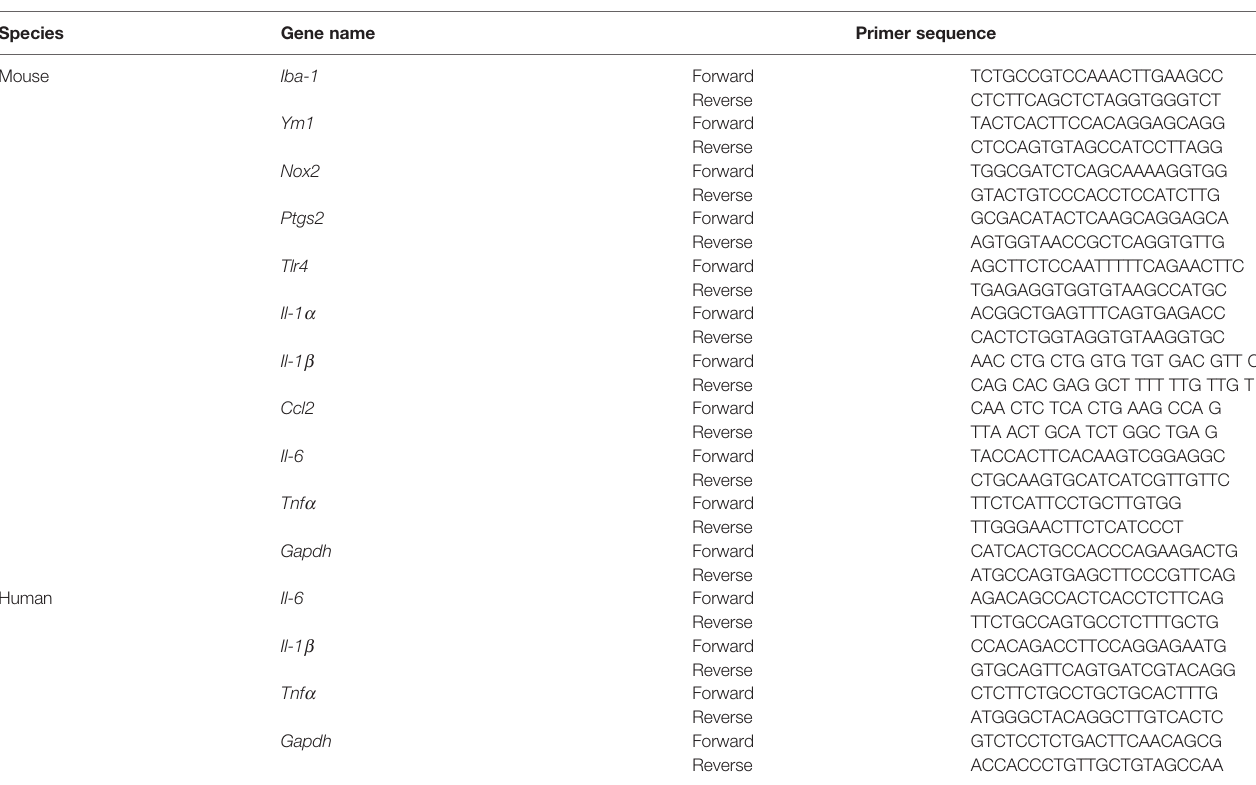
TABLE 1 | Primer sequences used in this study.